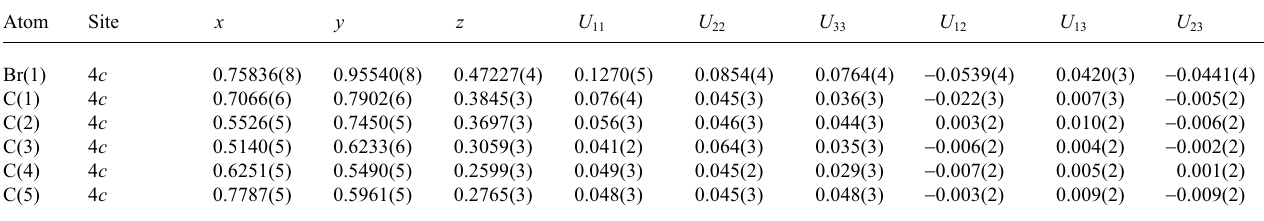
Table 3. Atomic coordinates and displacement parameters (in Å 2